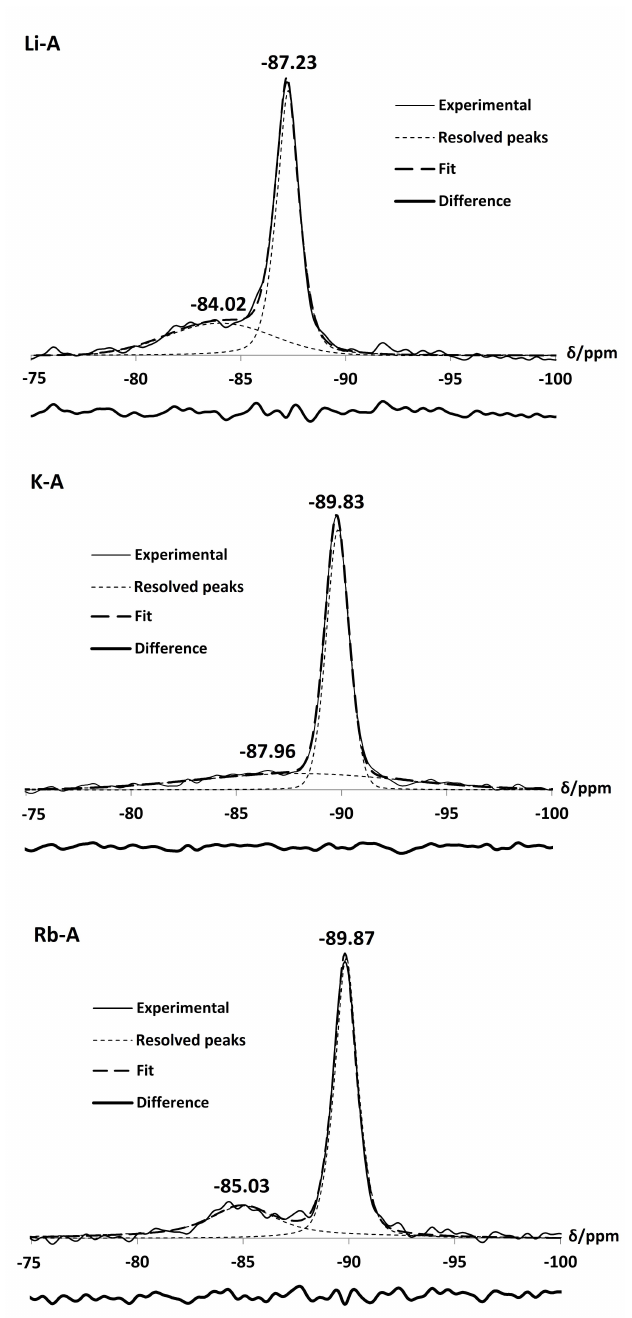
Figure 6. 29 Si NMR spectrum of the as-synthesised Na-A and monovalent cation-exchanged Li-A, K-A and